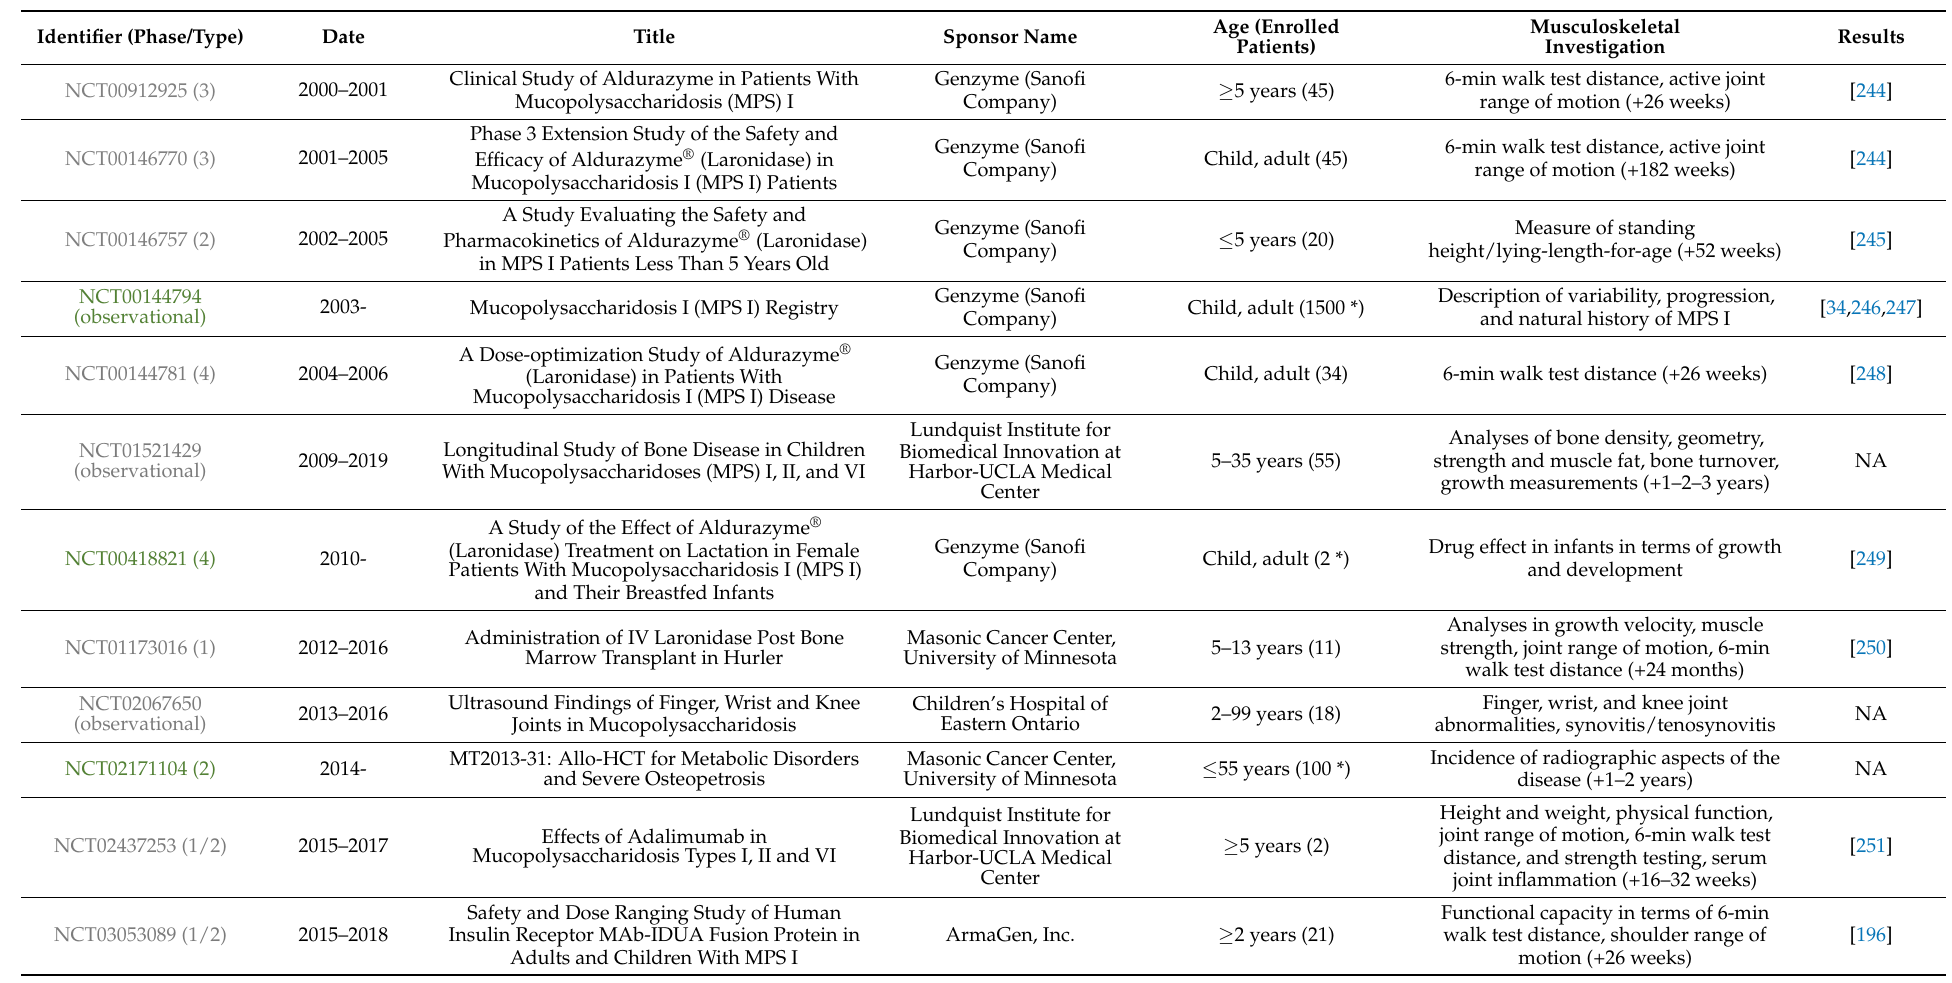
Table 1. Clinical trials with musculoskeletal investigations. List of recruiting (green), active and not recruiting (orange), not yet recruiting (blue), and terminated (gray) clinical trials from 2000 to 2022, with detailed planned analyses on bone manifestations. * Estimated patients’ enrollment, NA not